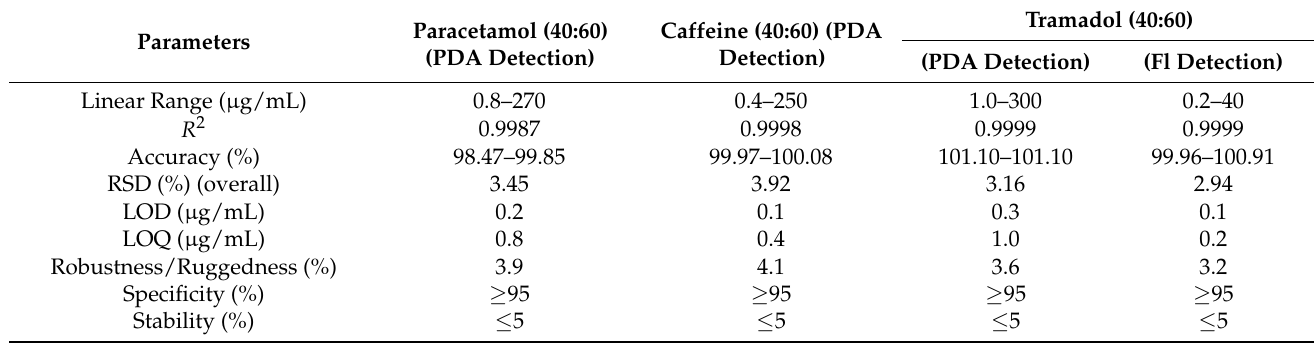
Table 2. Analytical characteristics of the developed method ( n =